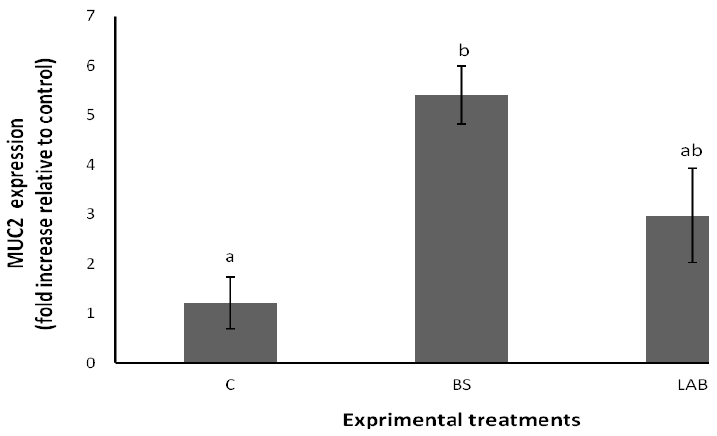
Figure 2. Result of the relative MUC2 gene expression data using real time qPCR according to 2 -  ct method. Means with different superscripts differ significantly (p<0.05). C = Control group (no addition probiotic); BS = Birds supplemented with Bacillus subtilis based probiotic; LAB = Birds supplemented with lactic acid bacteria based